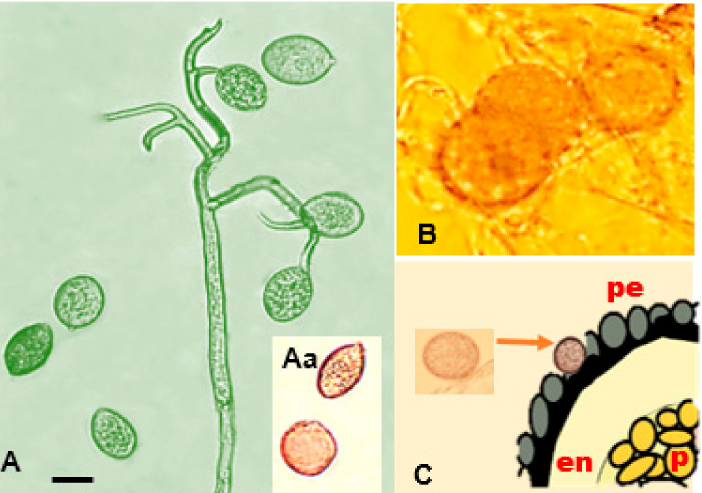
Figure 5. Peronospora variabilis spores isolated from C. quinoa. ( A ) Sporangiophore with lemon-shaped sporangia. ( Aa ) Oospores–sporangia size comparison. ( B ) Oospore on top of dried leaf tissue. Scale bars: 20 µ m (Photos: C. Colque-Little). ( C ) Schematic representation of oospore localization in quinoa seed. o = oospore; pe = pericarp; en = endosperm; p = perisperm (illustration adapted from Danielsen and Ames (2004) [54] and Prego et al. (1998)